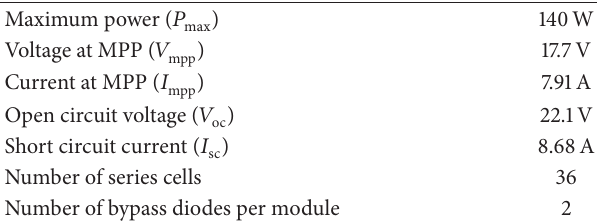
Table 1: Parameters of KD100-36 PV module at STC temperature is 25 ∘ C, Insolation is 1000W/m 2